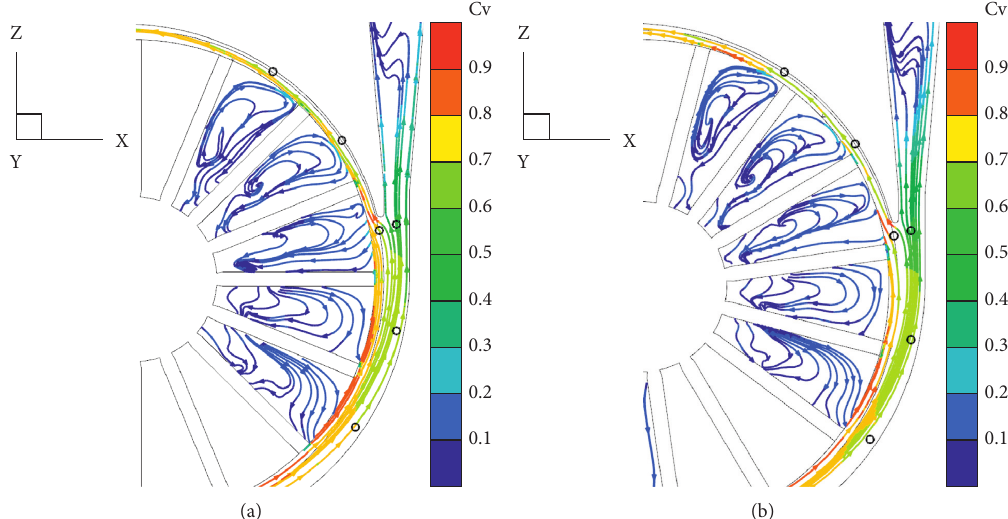
Figure 8: Streamline distribution of relative velocity in the central section of the impeller and the volute: (a) 1.0 Q peak and (b) 1.0 Q d at the pressure pulsation valley.